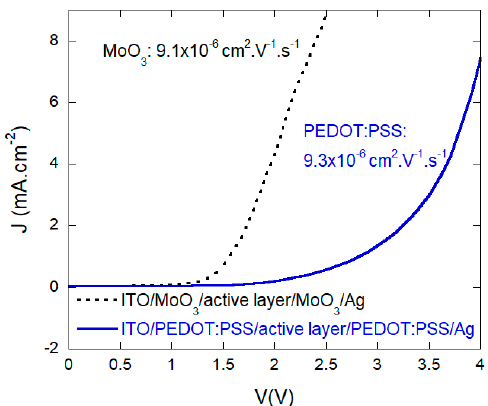
Figure 4. Dark J - V characteristics of P3HTN:PEG-C 60 hole only devices prepared using either MoO 3 or PEDOT:PSS as the hole transporting layer.